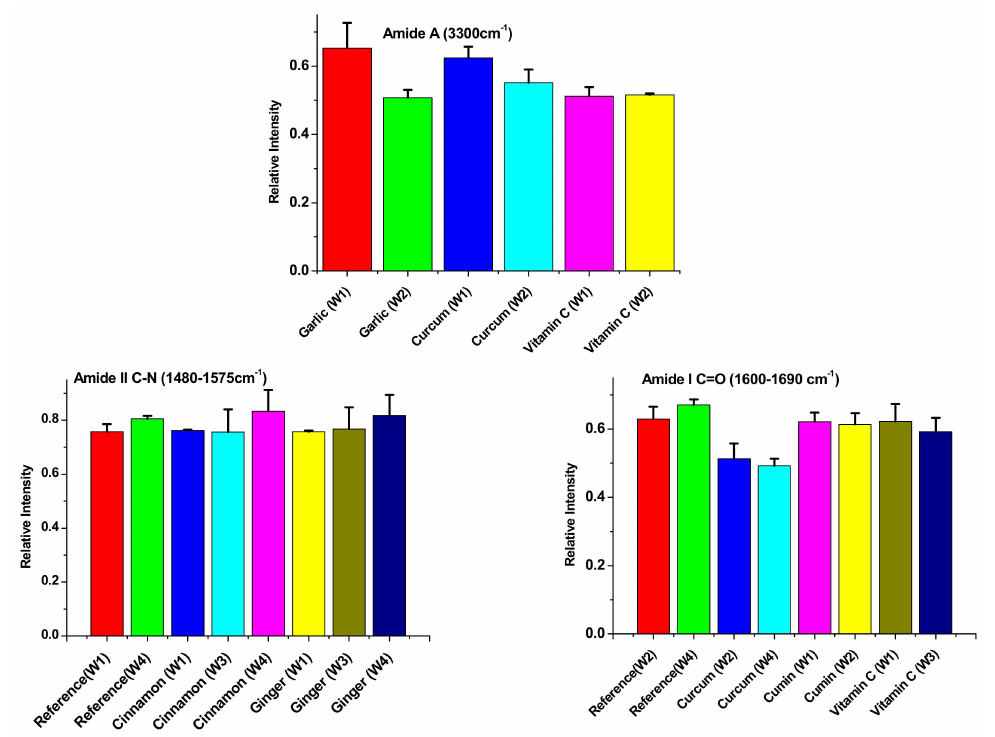
Figure 4. Amide-A intensity (3300 cm − 1 ); Amide II C-N (1430–1676 cm − 1 ) and Amide I C = O (1600 − 1690 cm − 1 ) for antioxidant treated and non-treated minced fillets of Ehrenberg’s Snapper at − 25.0 ◦ C at di ff erent timing from 1week to 4 weeks. Data are expressed as the mean ± SD, n =